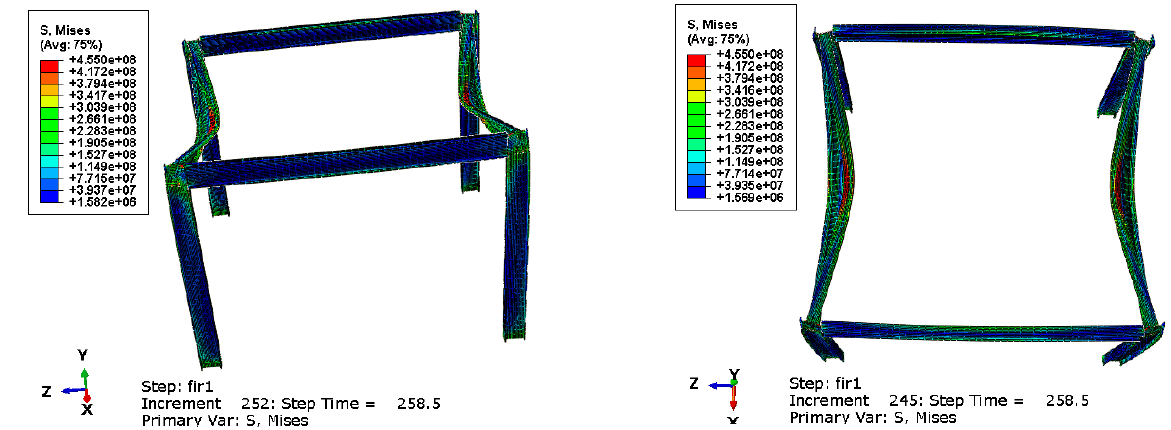
Figure 8. Failure mechanism (Fire-only scenario).